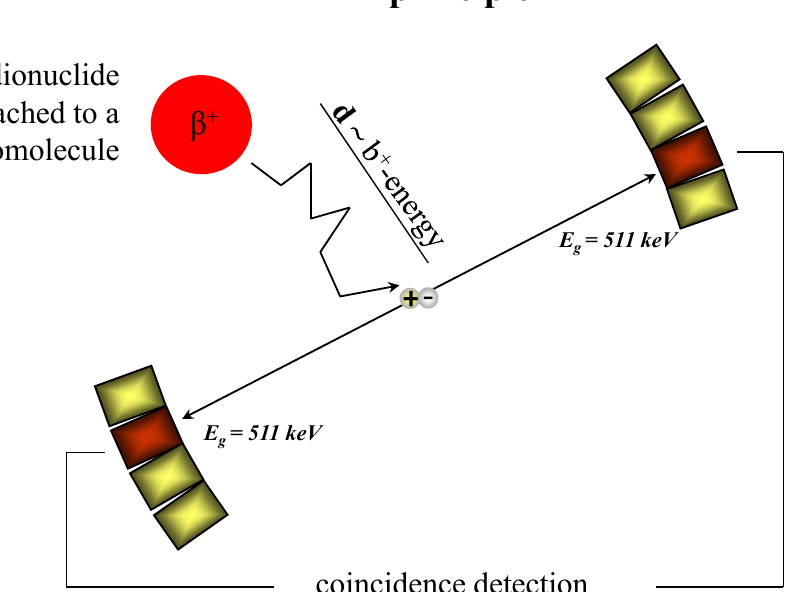
Figure 1. A β + emitting radionuclide (e.g., fluorine-18) is attached to a biomolecule. After the β + particle is emitted, it travels within the tissue, depending on its β + energy. After coming to rest, the β + forms a hydrogen atom-like system (with a positron instead of a proton center) with an electron from the surrounding environment and finally disintegrates under emission of two diametrically opposed gamma rays of 511 keV. These photons can be detected in “coincidence” (meaning at the same time within a certain time frame) and used for reconstruction of a 3D image of the radioactive decay and thus tracer